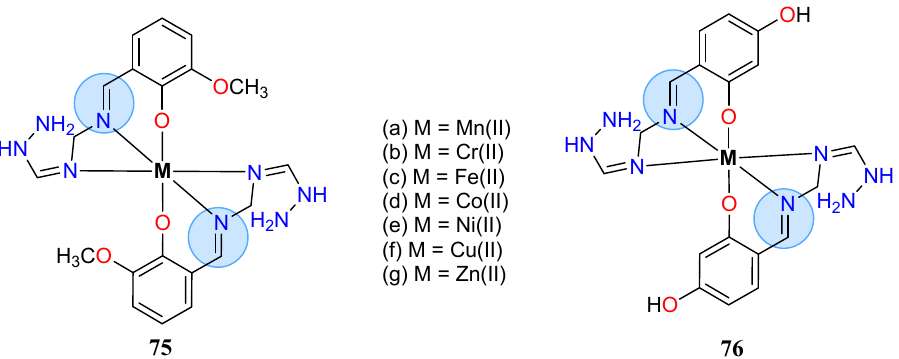
Figure 36. Metal complexes with Schiff base ligands (NNO) derived from 3-amino-1,2,4-triazole evaluated for their antimicrobial activity.